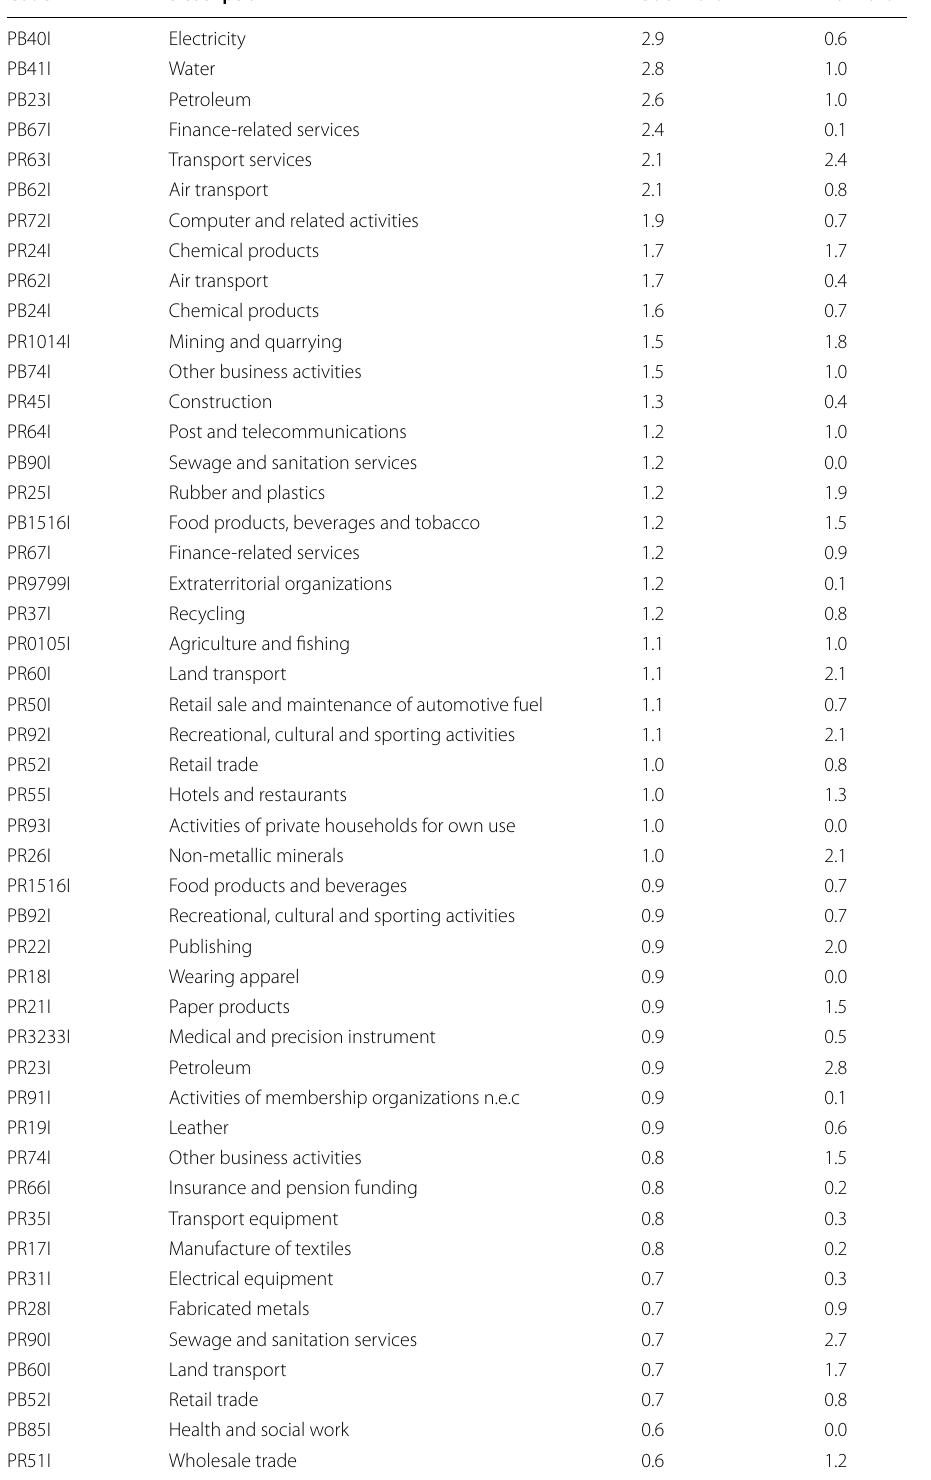
Table 3 Direct normalized linkages. Source: computed by the authors based on CSB (2013)